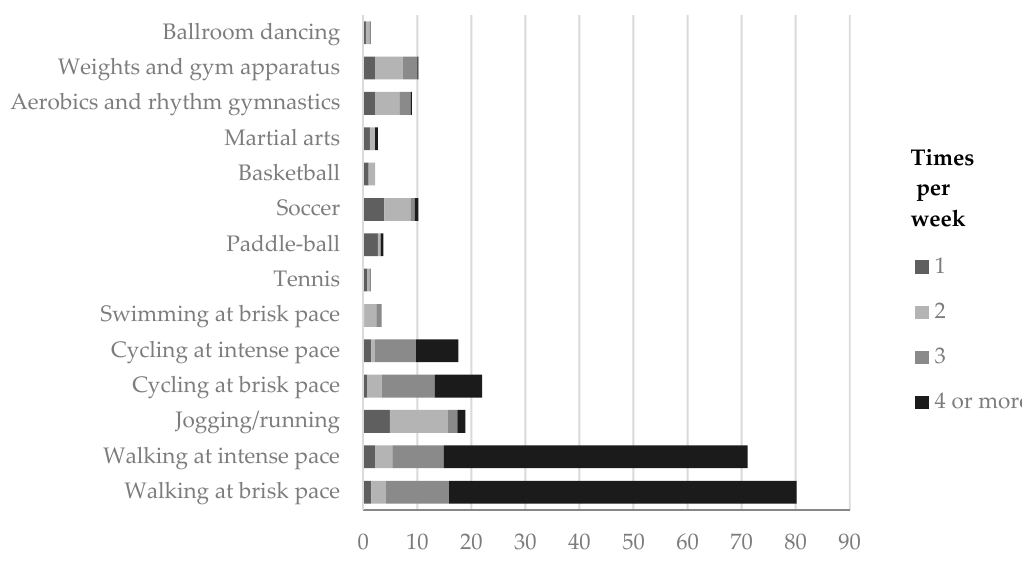
Table 2. Results of logit regression of LTPA.